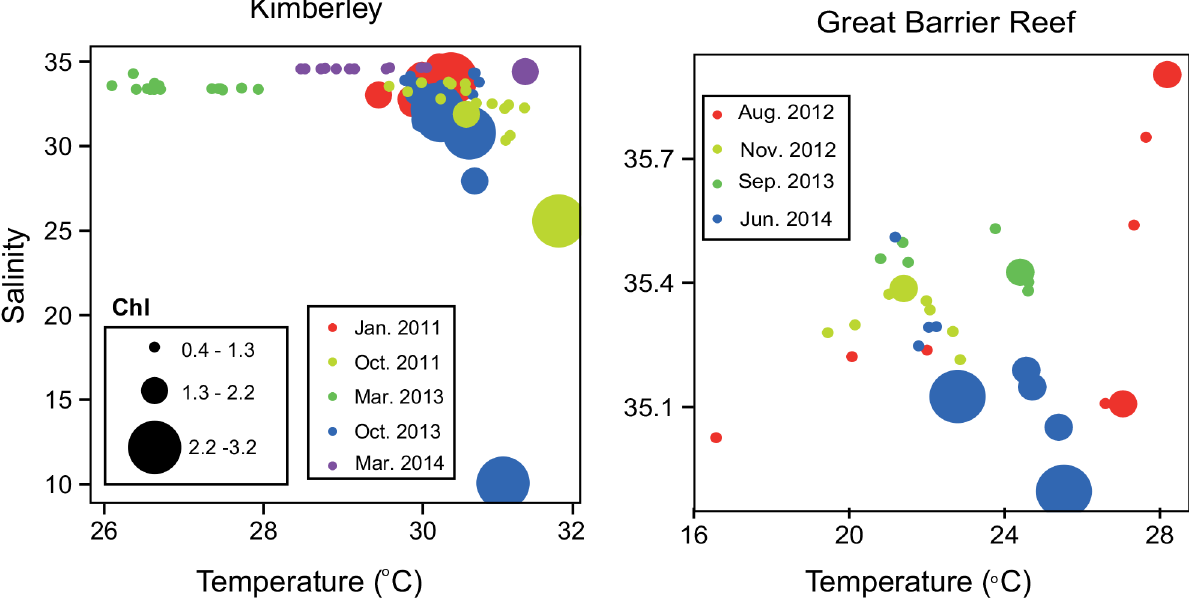
Fig 2. Temperature-Salinity-Chlorophyll diagrams for stations where enzyme assays were conducted. The numbers in this figure represent the means of temperature, salinity and fluorescence from the CTD casts over the full range of the water column. The hydrography for the Kimberley samples is further described in McKinnon et al.